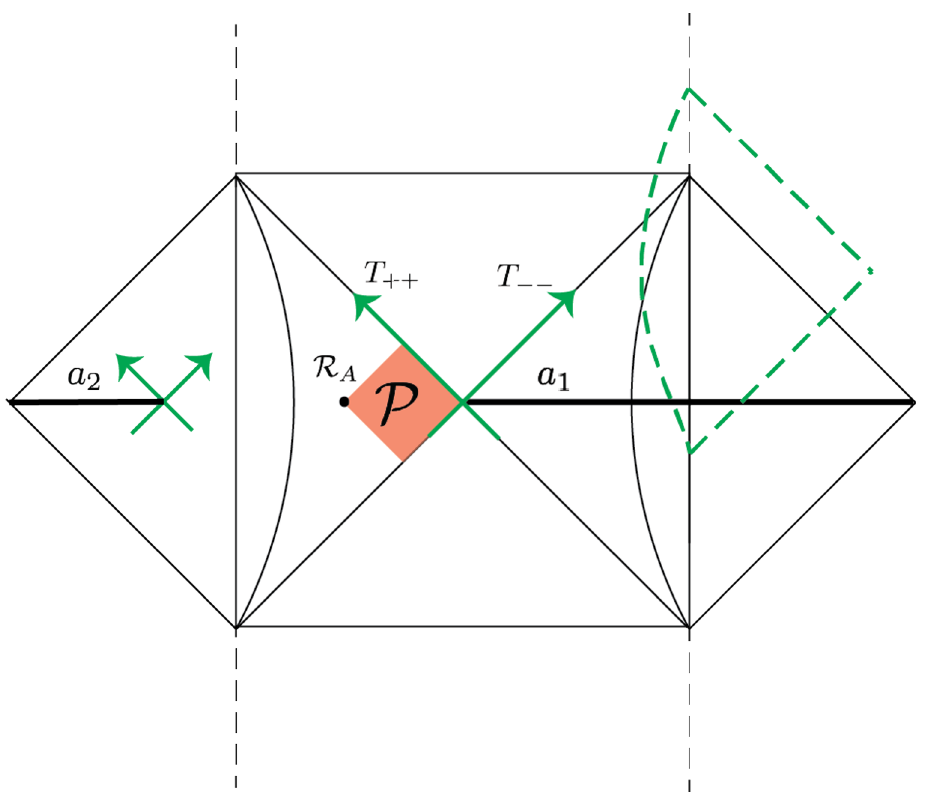
Figure 7 . We act with the two-sided unitary u s (Ω , a 1 ∪ a 2 ) on the vacuum as in (3.5). This has the effect of moving the right boundary particle’s trajectory to the dashed green line so that the whole peninsula P is in the past of the right boundary particle’s worldline, to leading order in large c . The shocks are labeled by the green arrows. For the purposes of seeing the peninsula, the left-most shocks are irrelevant, although they will have an effect on the left boundary particle’s trajectory, which is not shown. Also note that the regions denoted a are the s = 0 positions of the regions. 1 , a 2 Note that even though A , A are defined as fixed regions in the baths, their coordinate positions 1 2 change in the picture after we act with u . We caution that the main text only works to leading s order perturbatively and so we have exaggerated these effects in this